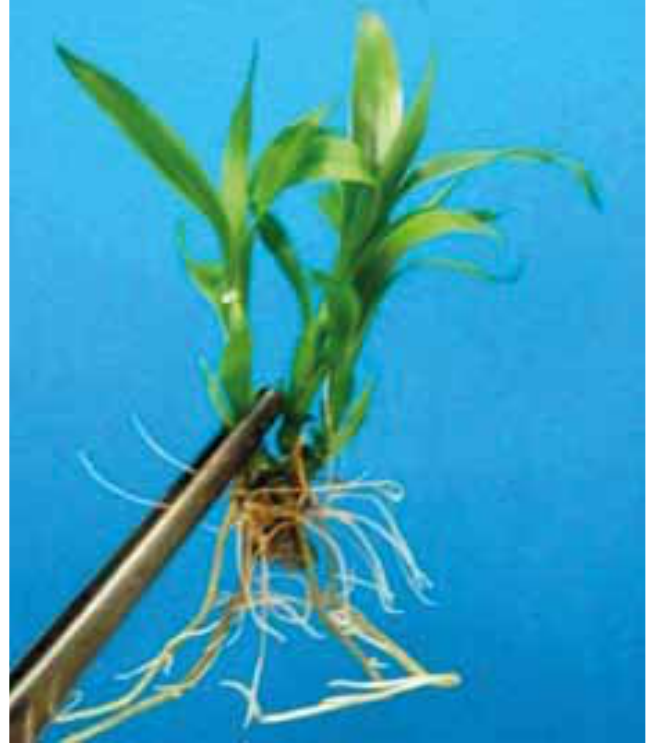
Fig. 2 - Shoots rooted on ½ MS medium containing 2 mg l -1 IBA, 30 days after